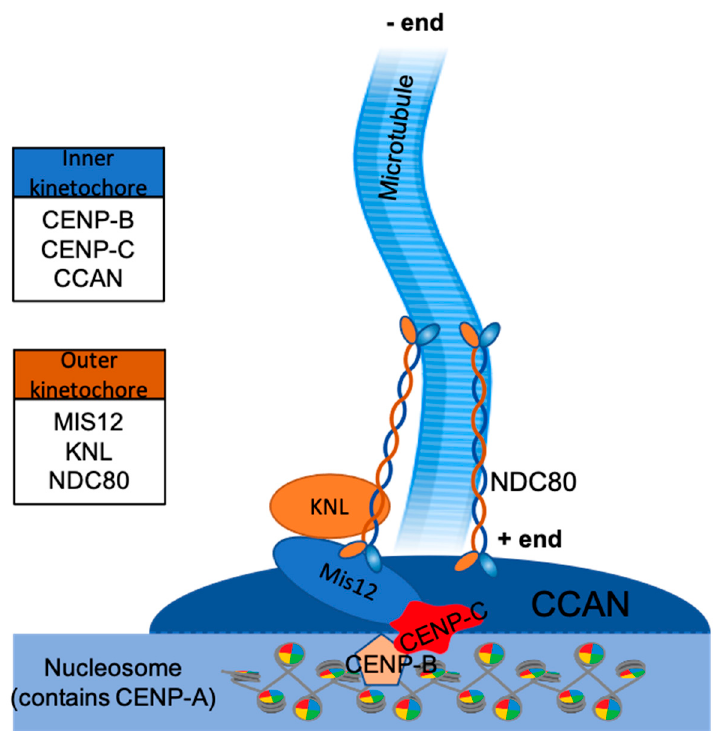
Figure 3. Proteins of KMN complex (KNL, Mis12, and NDC80) belong to the outer kinetochore layer, proteins of constitutive centromere-associated network (CCAN), CENP-B and CENP-C belong to the inner kinetochore layer. Together they form the required foundation for kinetochore-microtubule interface. Histone H3 is replaced by CENP-A belonging to the nucleosome. Microtubules attach to kinetochores at their plus ends, with minus ends being anchored to a microtubule organising centre (MTOC).